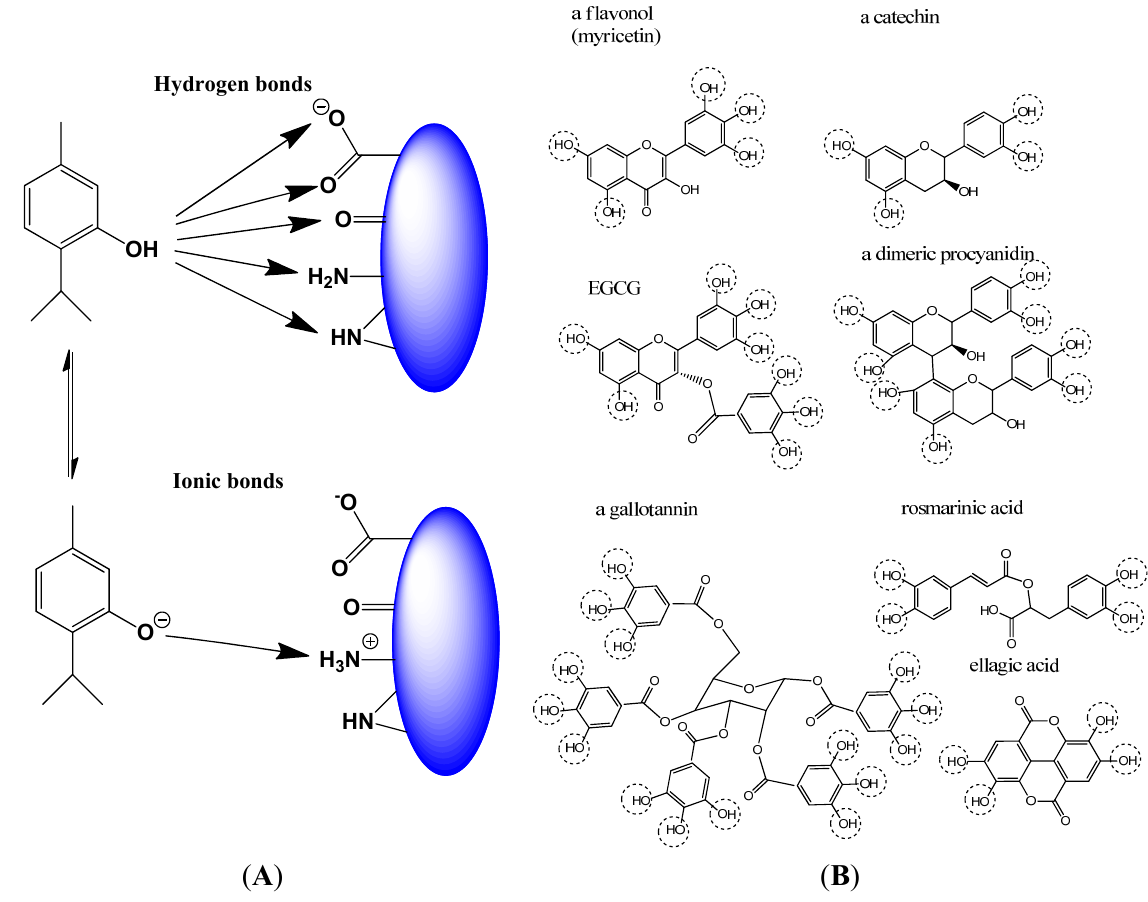
Figure 2. SM which form hydrogen and ionic bonds with proteins and thus modulate their conformation. ( A ) Schematic view of possible hydrogen and ionic bond formation by phenolic compounds (here thymol); ( B ) Examples for widely distributed polyphenols in medicinal plants. Phenolic OH groups are circled (after